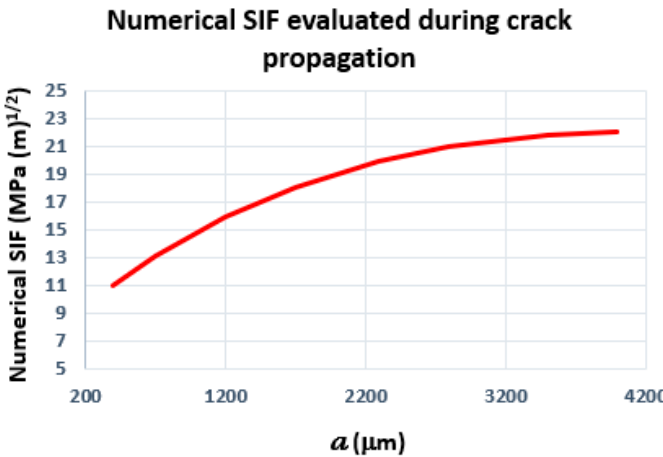
12 of 17 Figure 17. Crack propagation parameters used in numeric simulation. The numeric stress intensity factor in mode I was obtained taking the following sequence: •